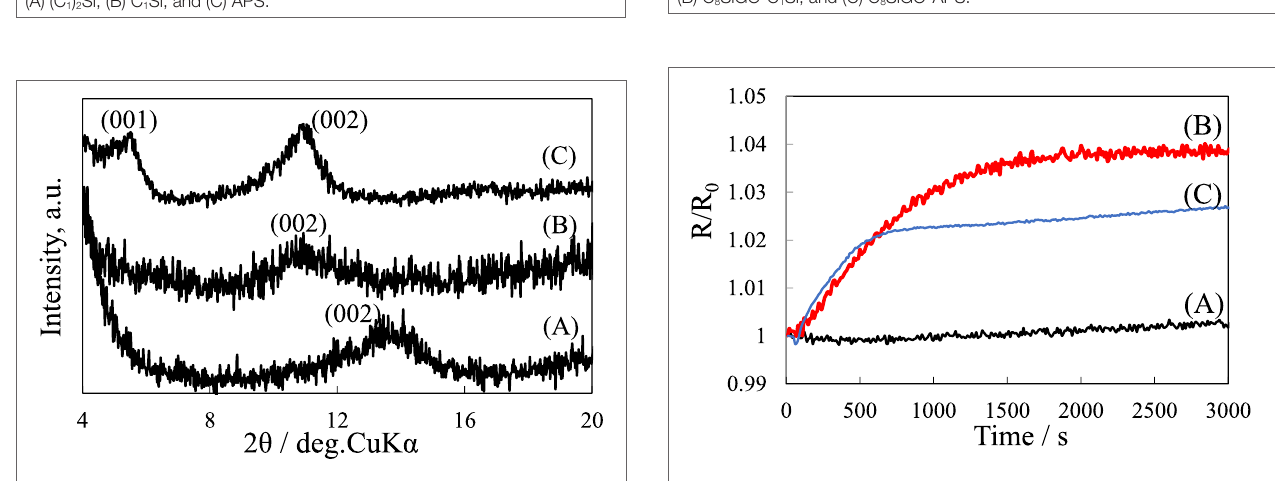
FigUre 3 | X-ray diffraction patterns of pillared carbons obtained from (A) C 8 SiGO-(C 1 ) 2 Si, (B) C 8 SiGO-C 1 Si, and (C) C 8 SiGO-APS.